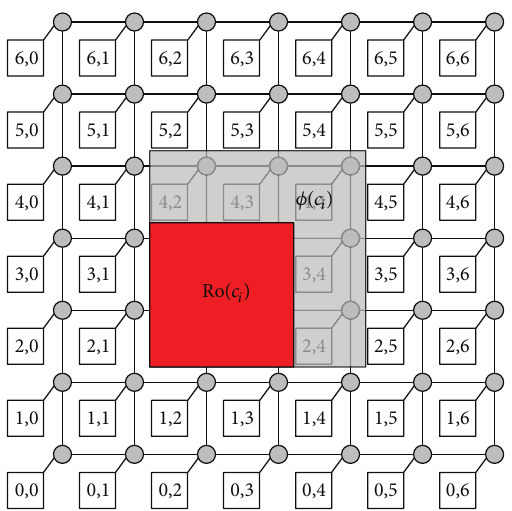
Figure 4: A region 𝑅(𝑐 𝑖 ) and a occupied region Ro (𝑐 𝑖 )